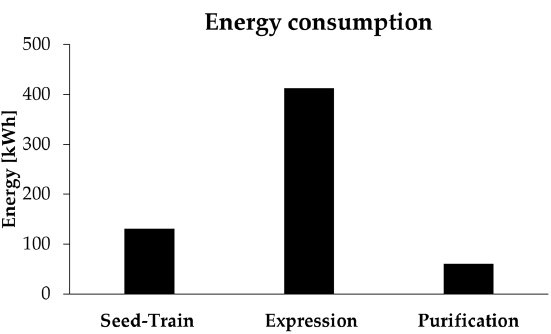
Figure 4. Energy consumption for the production of 10 g of enzyme during seed-train, protein expression and purification.